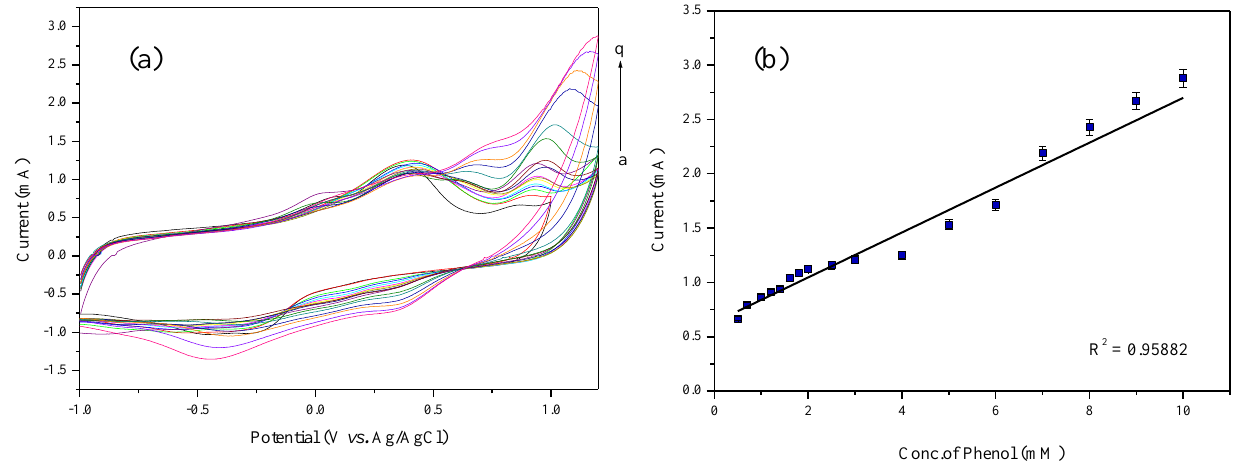
Figure 5. Cyclic voltammograms of microbial biosensor based on Cu in 0.1 M phosphate buffer solution (pH—7.0) (a) calibration curve of phenol concentration with respect to current (b)